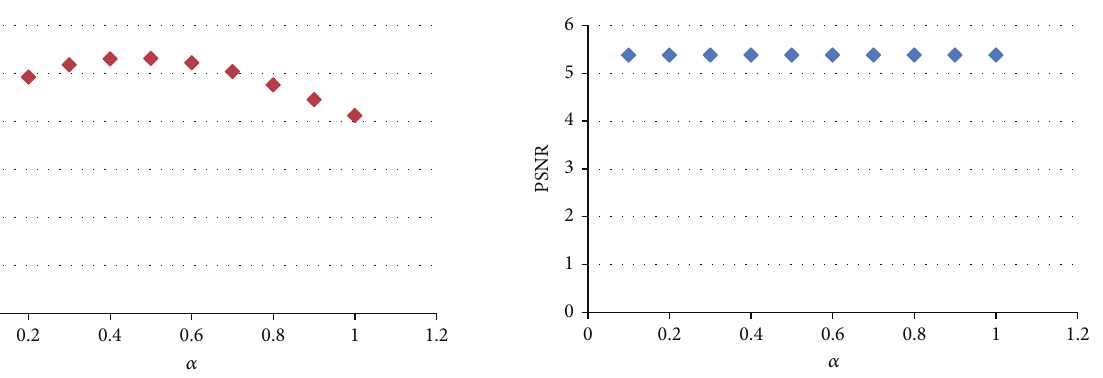
Figure 2: Choice of fractional 𝛼 at 𝛾 = 0.9 , for “Boat” corrupted by Gaussian noise with 𝜎 = 25 .